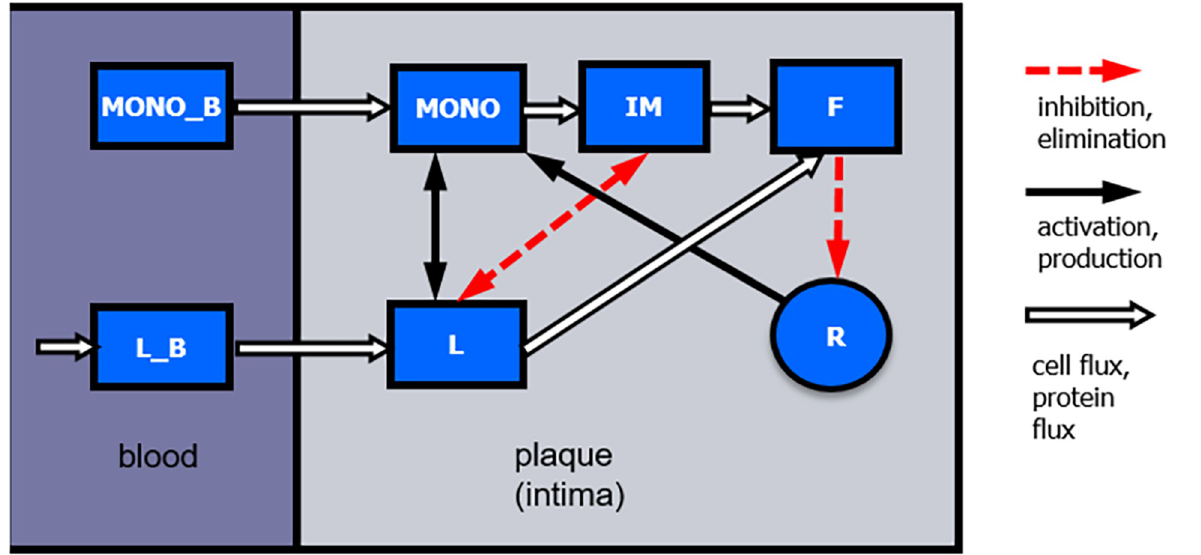
Fig 1. Structure of the model. The following compartments are considered: low density lipoprotein cholesterol (LDL-C) in blood (L B ) and plaque (L), monocytes in blood (MONO B ) and plaque (MONO), inflammatory macrophages in plaque (IM), foam cells in plaque (F) and the radius of the artery (R). Type and direction of arrows indicate fluxes or interactions.